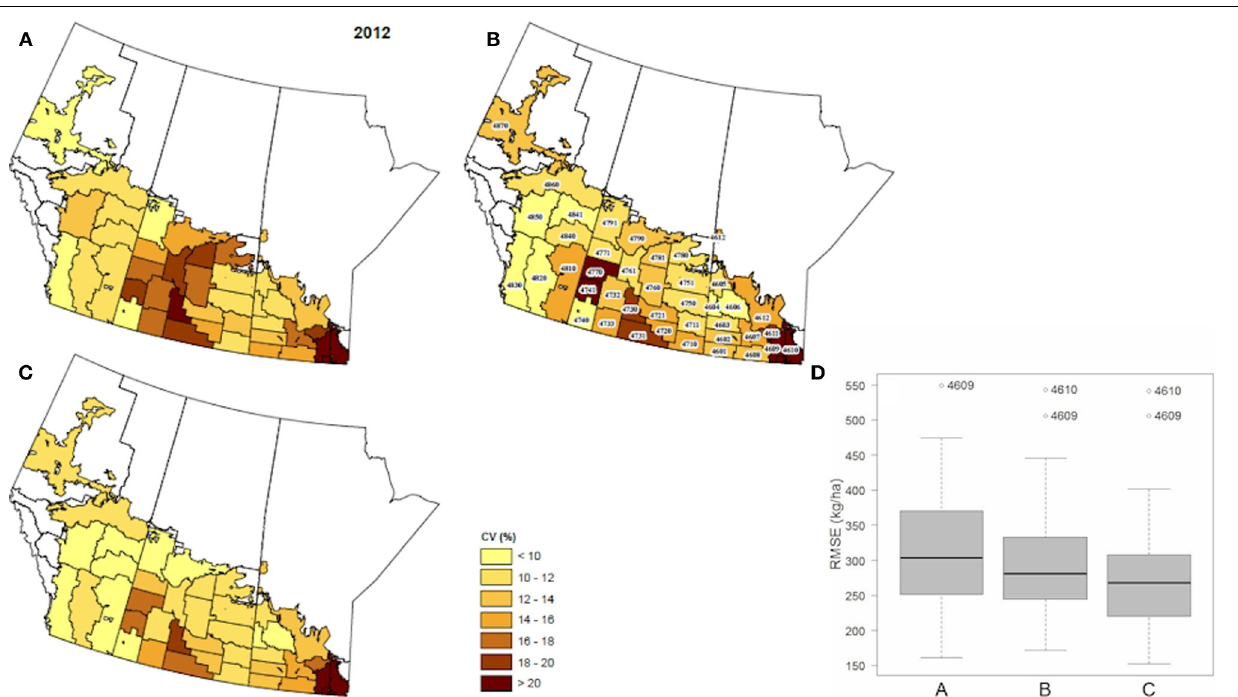
GDD, SWA), (B) NDVI, (C) WDI, GDD, SWA, P, NDVI. Right: (D) Forecasted error in 2012, pooled across all CARs for the different input cases (A–C)